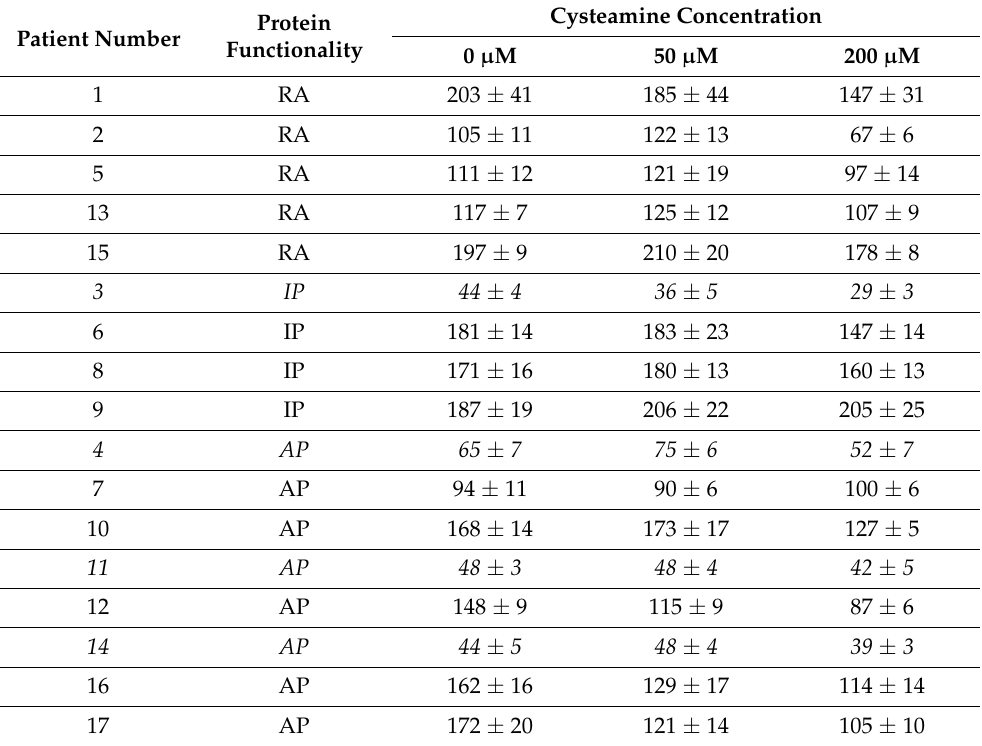
Table 4. Osteoclastic differentiation outcomes in each patient.